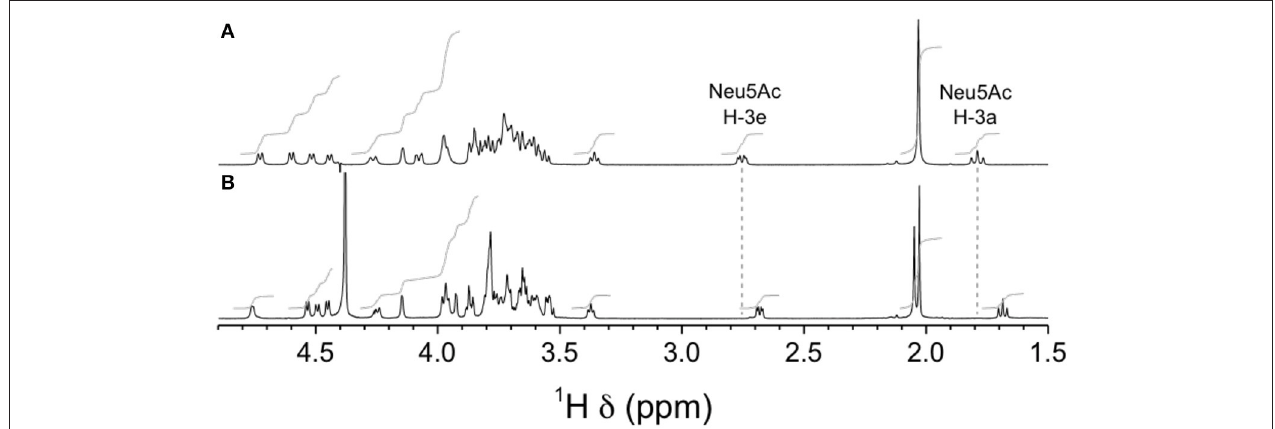
FIGURE 12 | 1 H NMR spectra of native GBS type III and mutant GBSIIIsia2,6 capsular polysaccharide (CPSs). (A) Wild-type GBS type III, D 2 O, 500 MHz, 90 ◦ pulse with presaturation, 62 ◦ C. (B) GBSIIIsia2,6 ( 1 cps3K / cps2N ) mutant, 33mM phosphate pD 8.0 in D 2 O, 700 MHz, 90 ◦ pulse, 65 ◦ C.